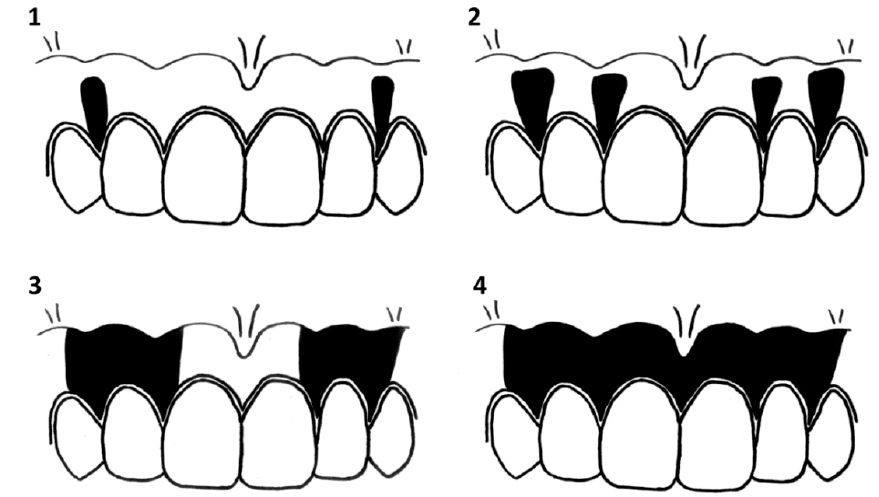
Figure 2. Hedin’s classification (degrees 1–4).